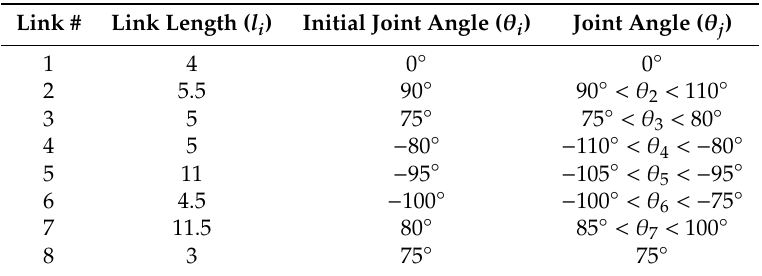
Table 1. Denavit–Hartenberg (D–H) parameters of a walking soft robot. Table 1. Denavit – Hartenberg (D – H) parameters of a walking soft robot.